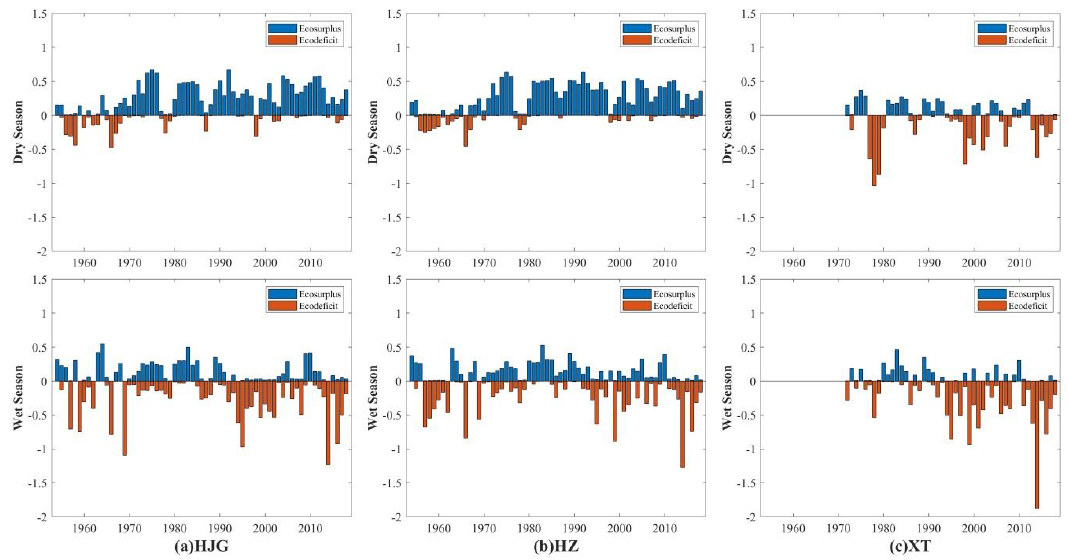
Figure 5. Boxplots of the seasonal ecosurplus and ecodeficit during four periods in the stations.